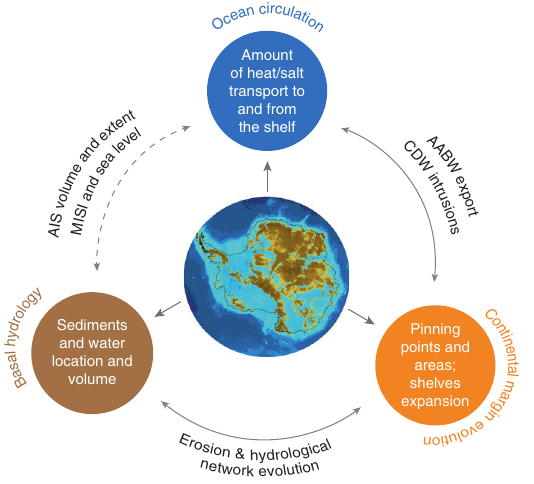
Fig. 6 Main gaps identi fi ed for the three realms discussed in the review (colored circles). Each major gap spans present-day and past processes, and results from the lack of information about past and present topography and bathymetry (at the center), which severely limits our understanding of future AIS evolution. The largest unknowns are the processes and interactions at the interfaces between each realm (arrows), which urgently require cross-disciplinary research. The impact of sub-shelf ocean circulation on ice-sheet dynamics across the grounding zone (dashed arrow) is one of the least understood feedbacks and could contribute to processes leading to